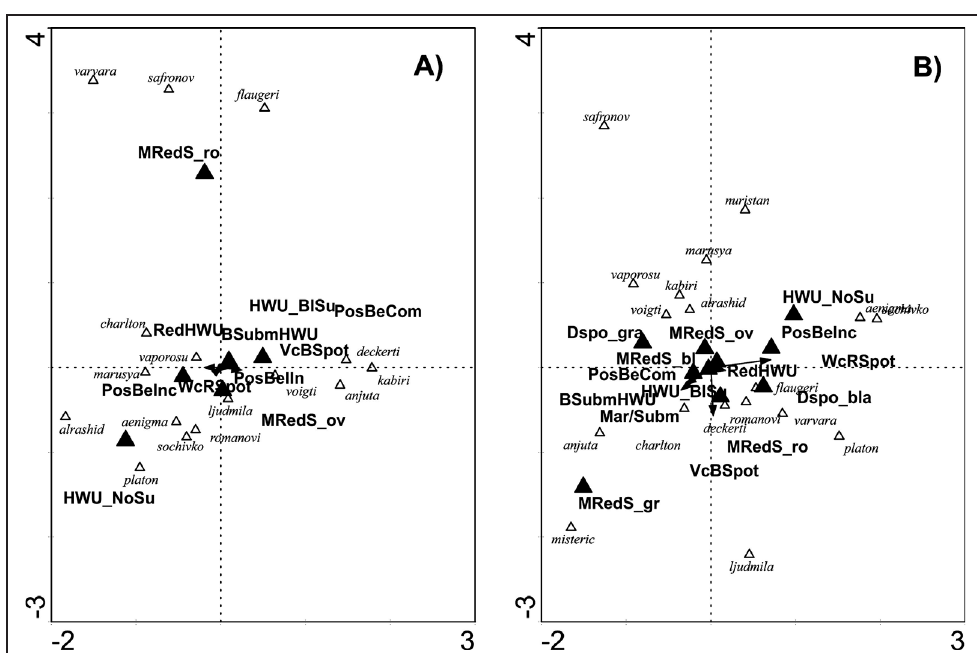
Figure 6. Ordination plots of CCA analyses of variables of wing pattern elements on subspecies of K. charl- tonius . A ) males, B ) females. Plotted are ordination axes 1 and 2. Continuous variables are plotted as arrows, dummy variables as white triangles. Black triangles represent the centroid of